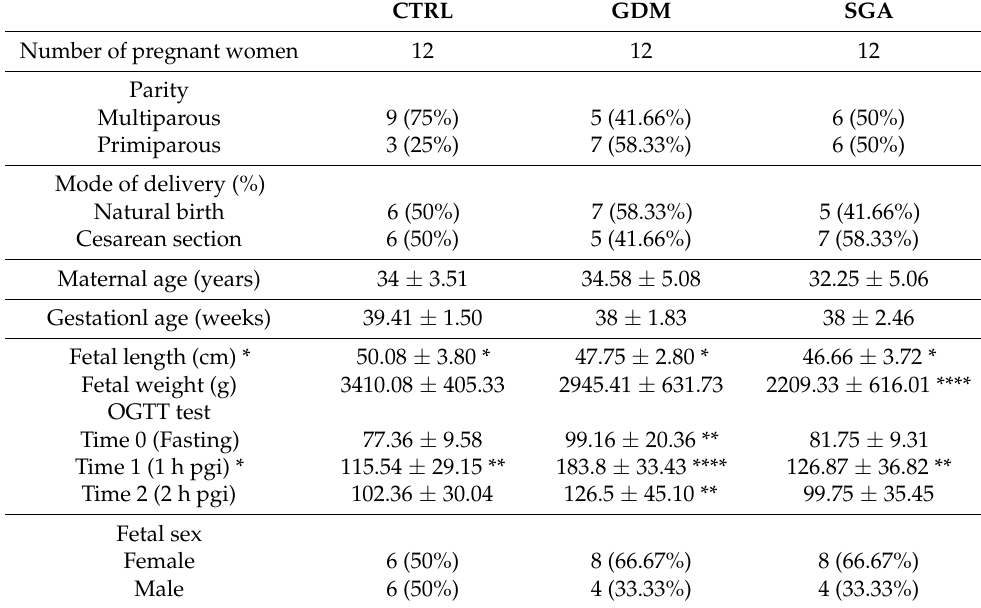
Table 1. Clinical characteristics of the patients and parameters used for the diagnosis of GDM and Scheme 0. Was considered as statistically significant compared to CTRL group. * Corresponds to p < 0.05, ** corresponds to p < 0.01, and **** corresponds to p < 0.0001. pgi: post glucose intake. CTRL GDM SGA Number of pregnant